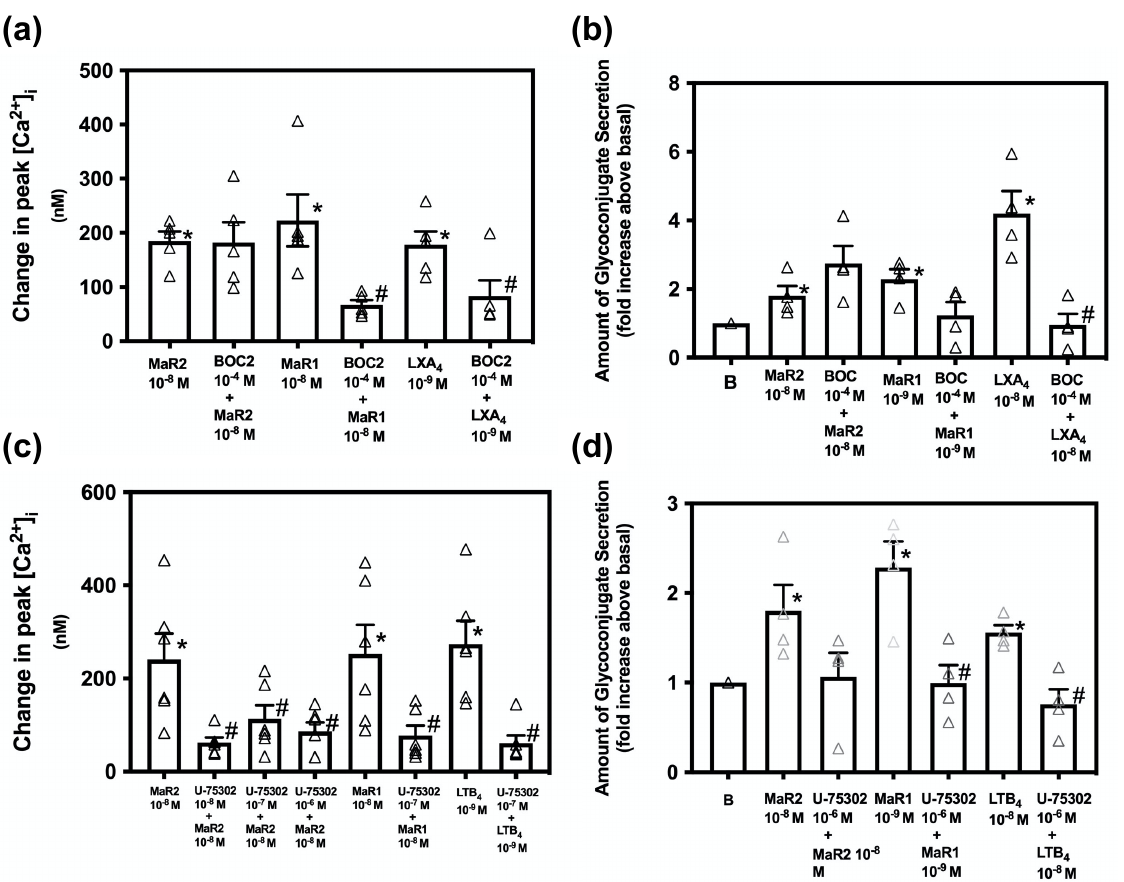
Figure 3. Inhibition of the BLT1, but not the ALX/FPR2 receptors acts on stimulation of [Ca 2+ ] i and secretion by MaR2. Goblet cells were treated with the ALX/FPR2 receptor inhibitor BOC2 (10 − 4 M) for 30 min and stimulated with MaR2 10 − 8 M ( a , b ), MaR1 10 − 8 M ( a ) MaR1 10 − 9 M ( b ), LXA 4 10 − 9 M ( a ) or LXA 4 10 − 8 M ( b ). Goblet cells were treated with the BLT1 receptor inhibitor U-75302 (10 − 8 –10 − 6 M) for 30 min and stimulated with MaR2 10 − 8 M ( c , d ), MaR1 10 − 8 M ( c ), MaR1 10 − 9 M ( d ) or LTB 4 10 − 9 M ( c ) LTB 4 10 − 8 M ( d ). [ Ca 2+ ] i was measured in ( a , c ); secretion in ( b , d ). Data are mean ± SEM of five ( a ), four ( b ), six ( c ) and four ( d ) experiments. White triangles indicate individual data points. * shows significance above basal. # shows significance between agonist and inhibitor + agonist.